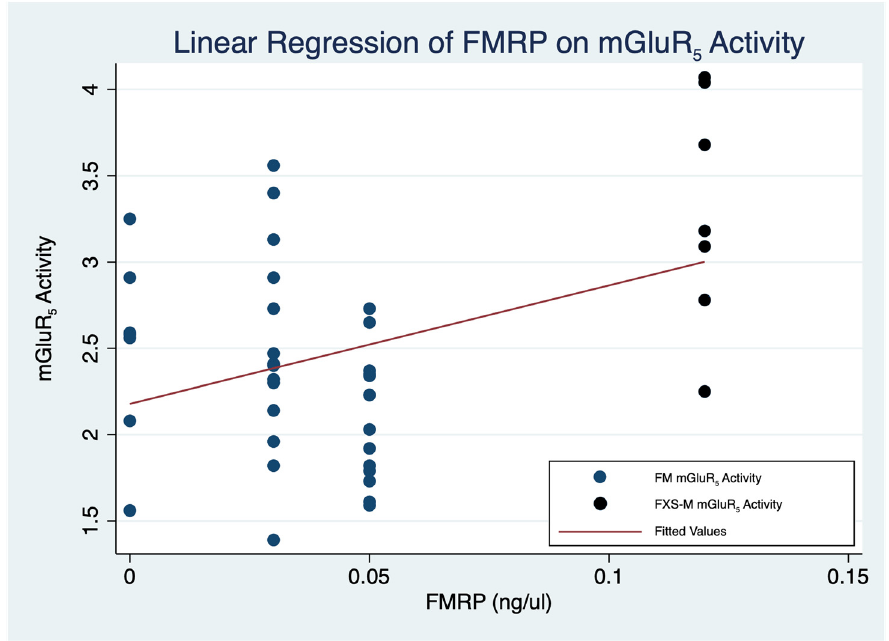
Figure 3. Linear regression of 3-[ 18 F]fluoro-5-(2)pyridinylethynyl)benzonitrile ([ 18 F]FPEB) uptake on FMRP in men with a FM and an FXS-M of FXS (F(7,47) = 6.84, p < 0.001) (StataCorp. 2021. Stata Statistical Software: Release 17. College Station, TX: StataCorp LLC.) (Table 5). FM: Full mutation; FMRP: Fragile X Mental Retardation Protein; FXS: Fragile X syndrome; FXS-M: FXS-M: Allele size mosaicism of fragile X syndrome